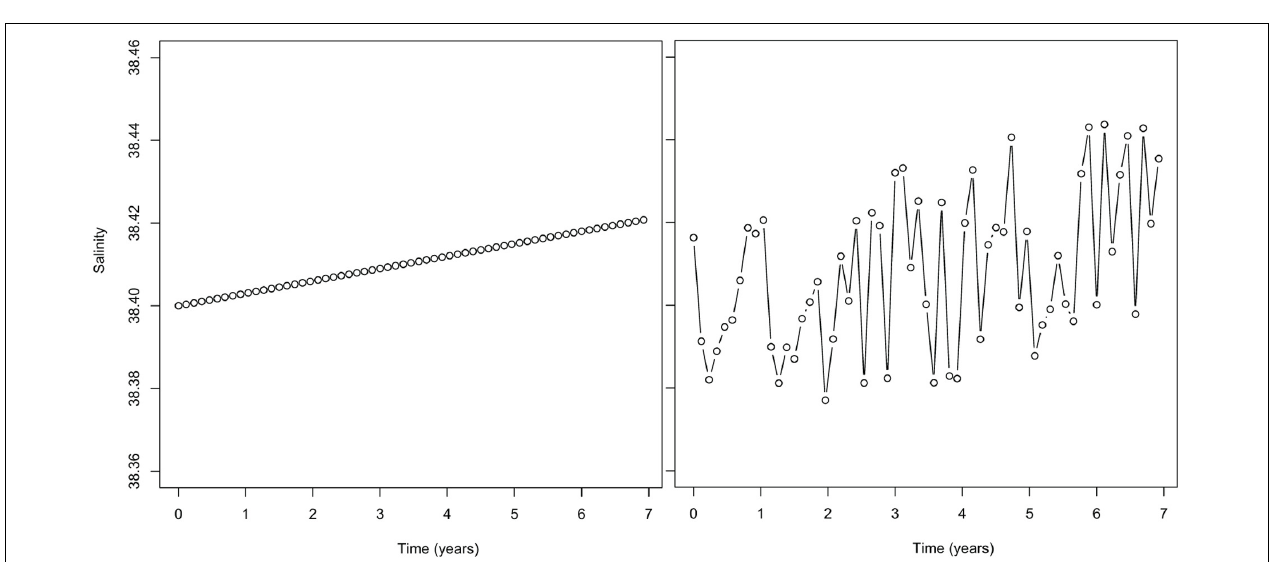
FIGURE 2 | Seven years of a 0.003-psu modeled salinity trend beginning at 38.400 psu (left) and with the addition of white noise modeled measurement error of maximum magnitude 0.030 psu (right).